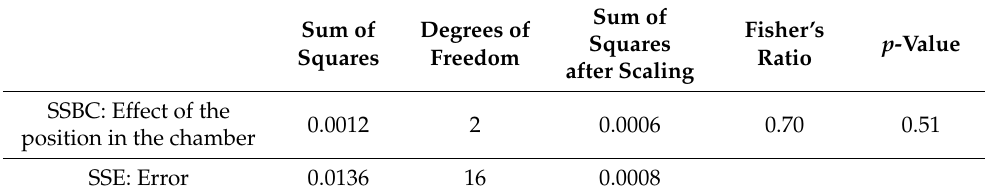
Table 4. ANOVA Table regarding the effect of the position in the chamber on the fatigue strength. Sum